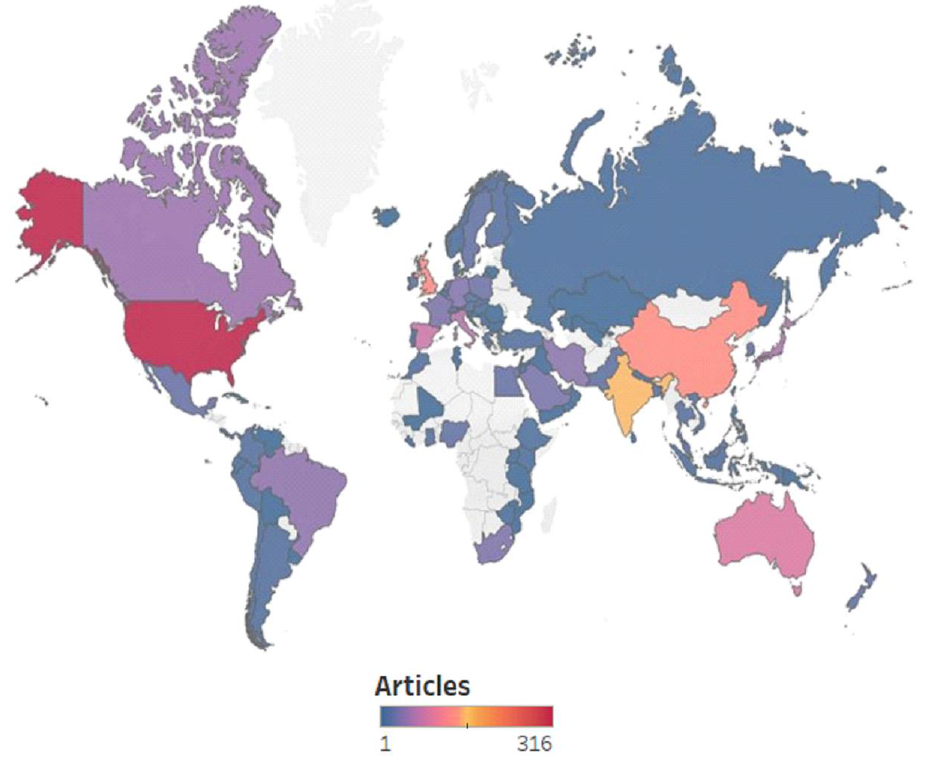
Figure 7. Geographical distribution of scientific productivity—articles.